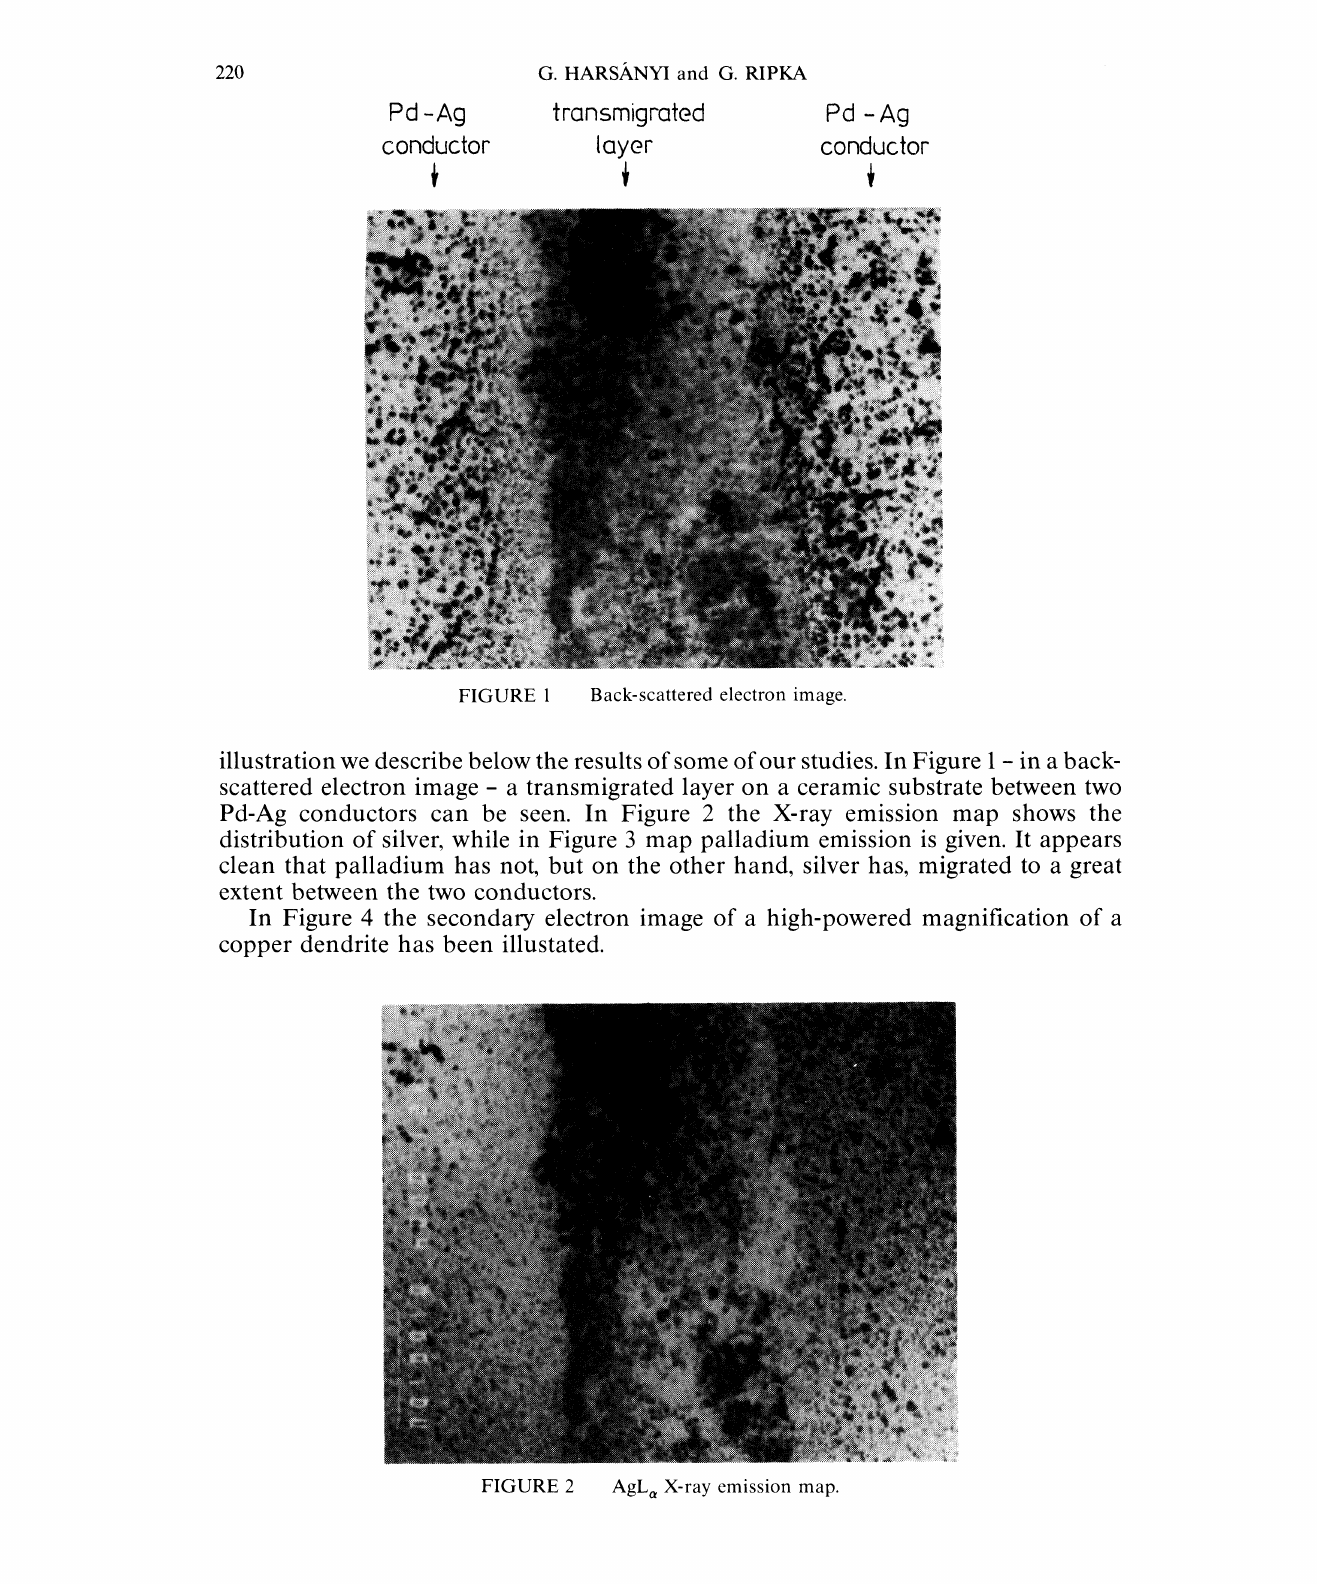
FIGURE 2 AgL X-ray emission